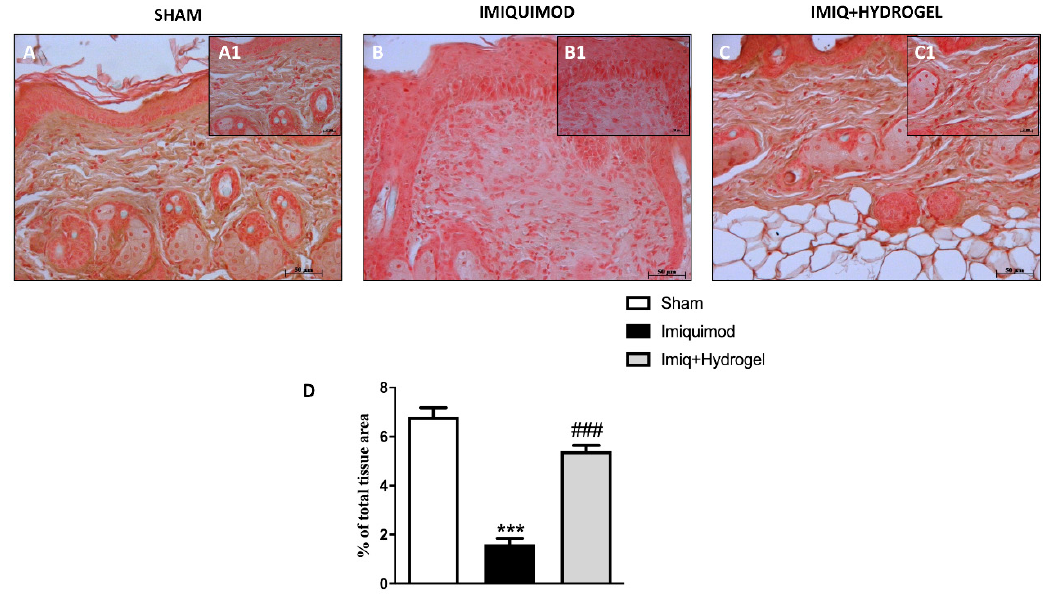
Figure 4. E ff ect of Hydrogel treatment on Occludin expression. The Occludin expression was analyzed by immunohistochemistry. Endogenous expression of Occludin has been found in the slides of sham-operated mice ( A magnification 20 × , A1 magnification 40 × , D ), IMQ administration reduced this expression ( B magnification 20 × , B1 magnification 40 × , D ). However, Hydrogel treatment increased the positive staining to Occludin ( C magnification 20 × , C1 magnification 40 × D ). Data are representative of at least three independent experiments; One-Way ANOVA test. *** p < 0.001 vs. sham; ### p < 0.001 vs. IMQ .